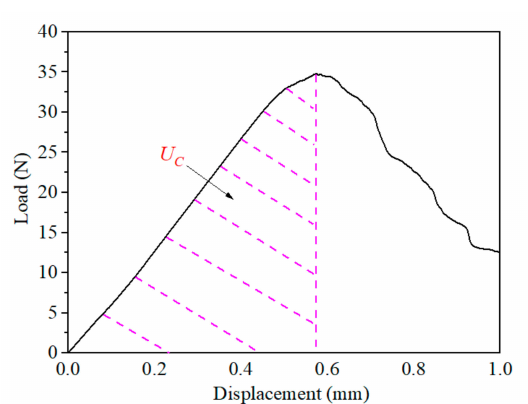
Figure 3. Typical load – displacement curves from the CT specimen experiments at various temperatures (a / W = 0.4).